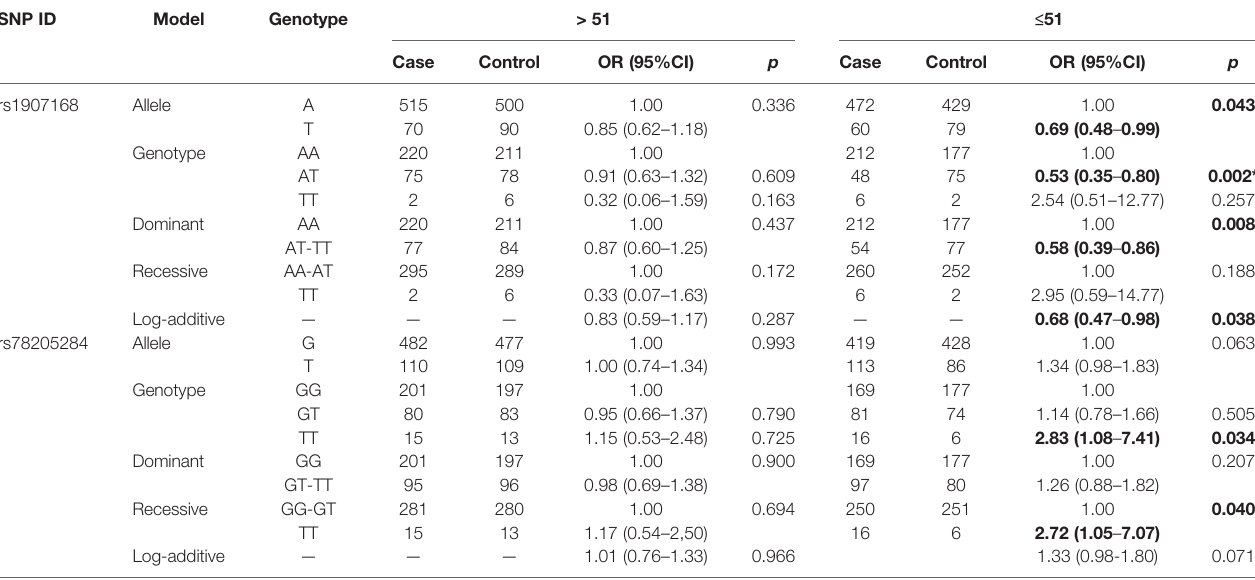
TABLE 3 | Relationships between LRRC3B polymorphisms and breast cancer risk according to the strati fi cation by